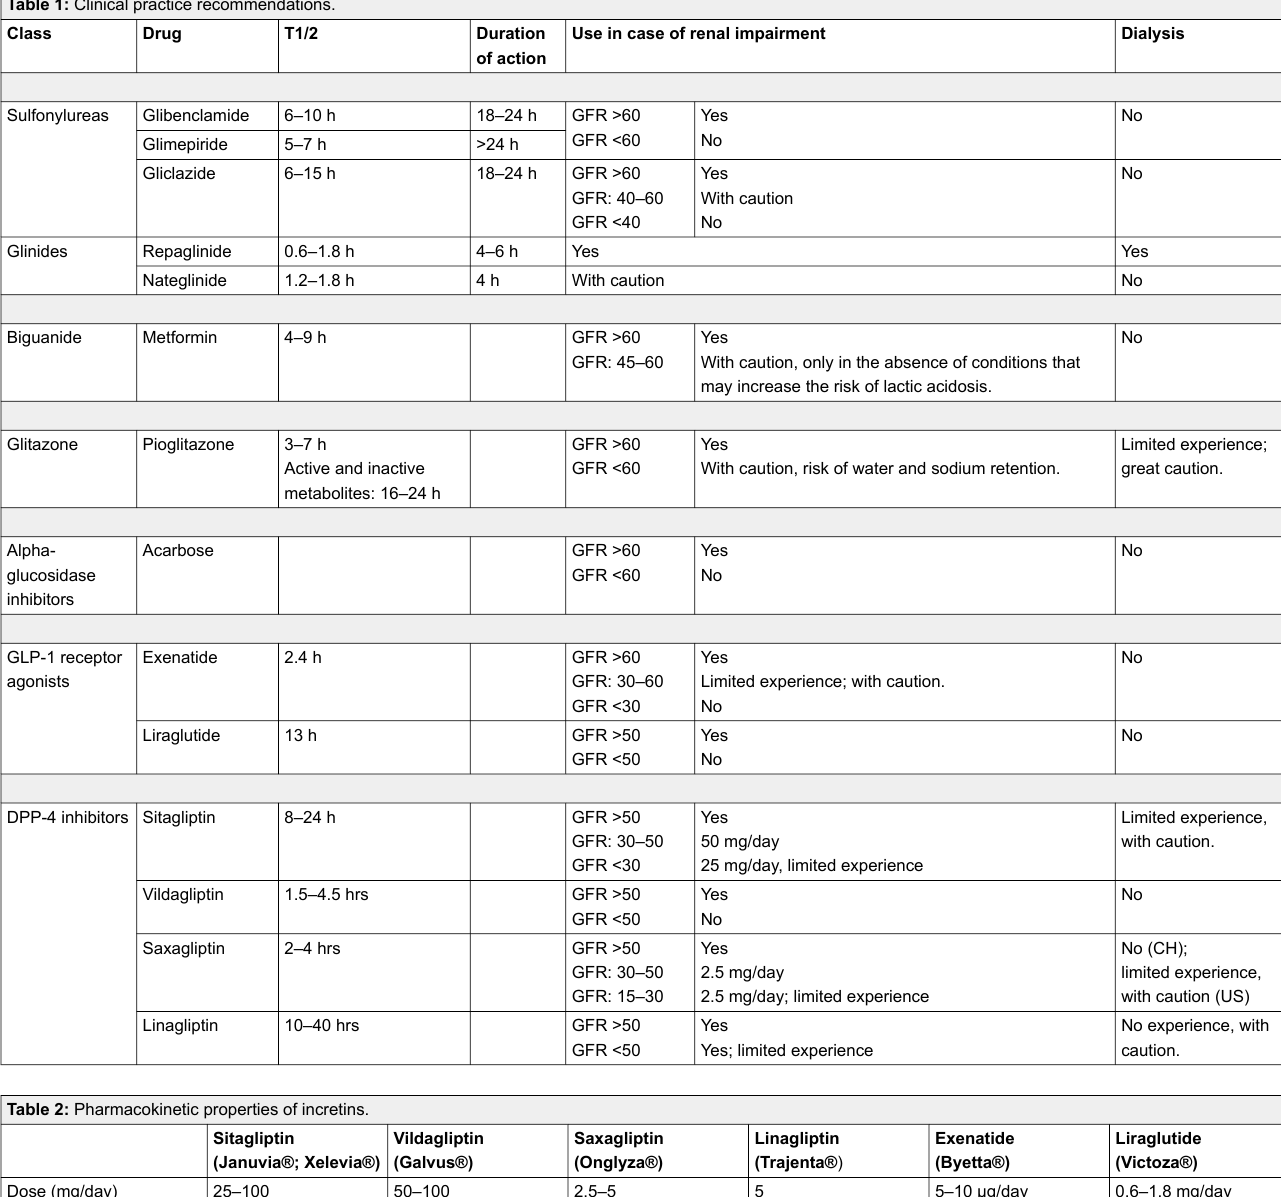
Table 1: Clinical practice recommendations.